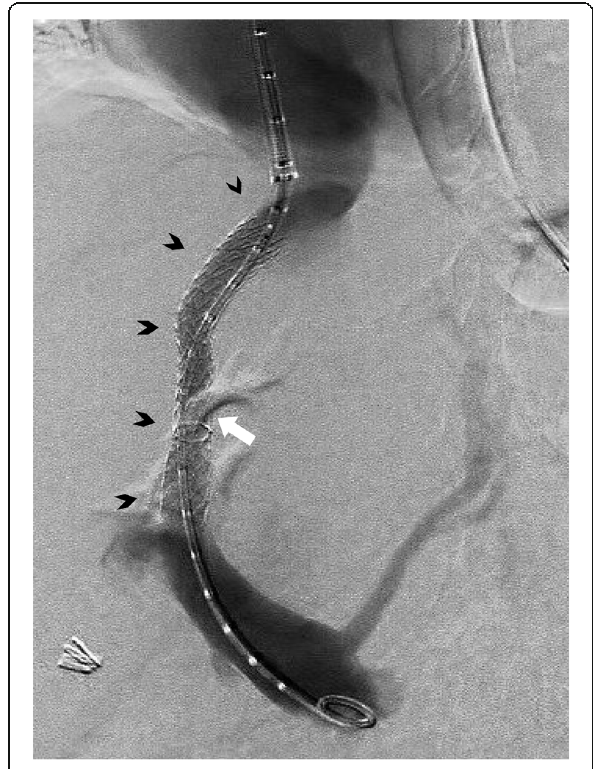
Fig. 1 Primary TIPS extending from right hepatic vein to left portal vein with Viatorr stent in situ (arrowheads). Venography confirms a widely patent shunt. Extravascular contrast is obscuring part of the stent at the portal entrance